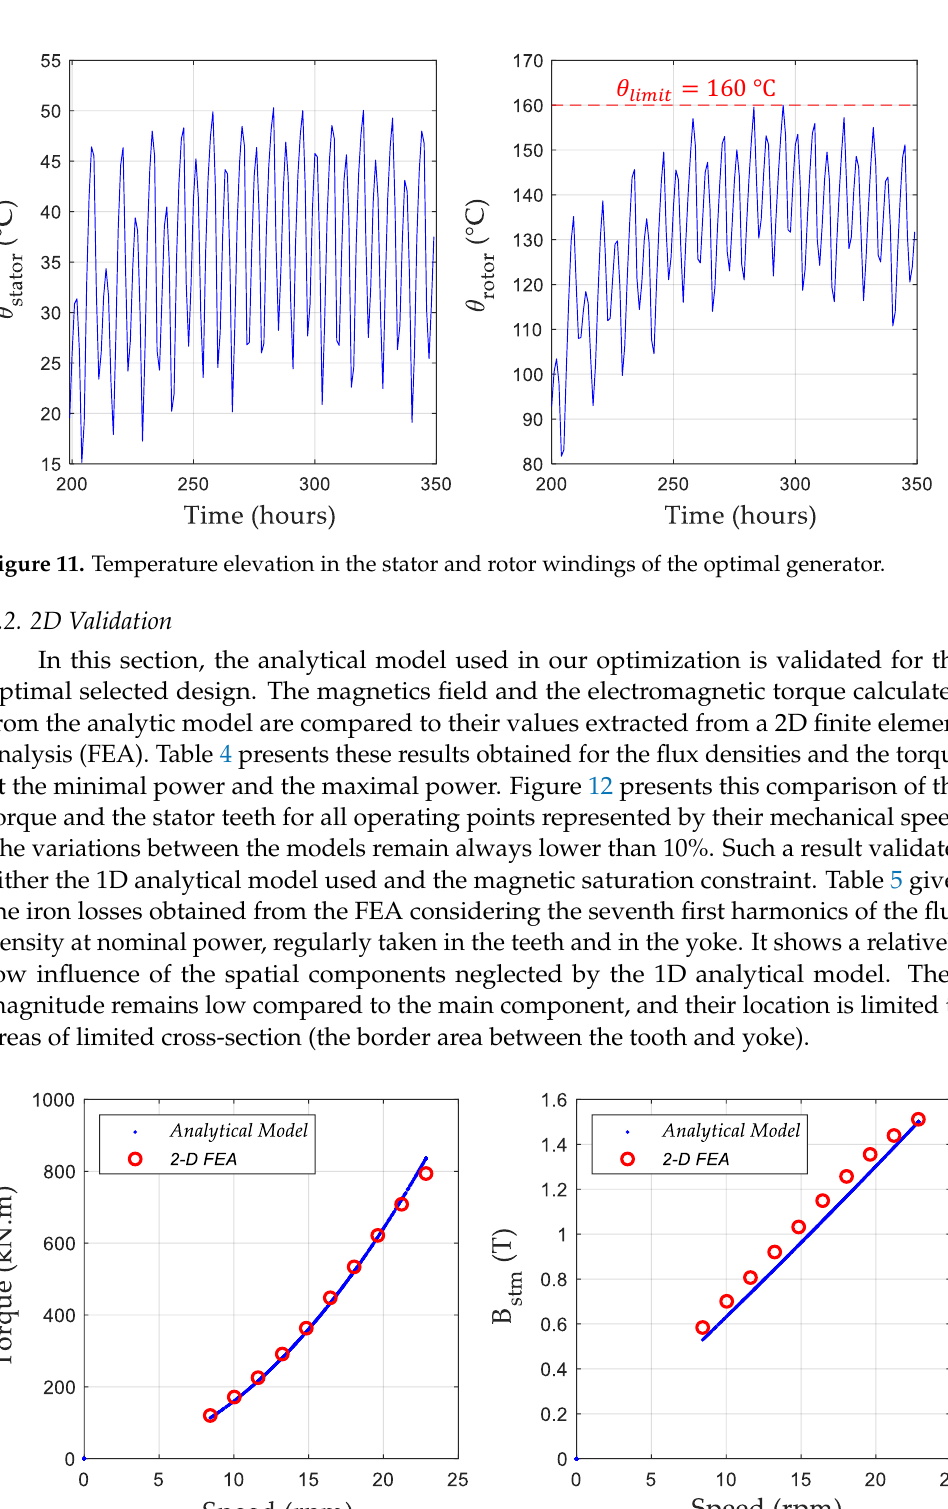
Figure 12. Torque and flux density in the stator teeth with the speed.